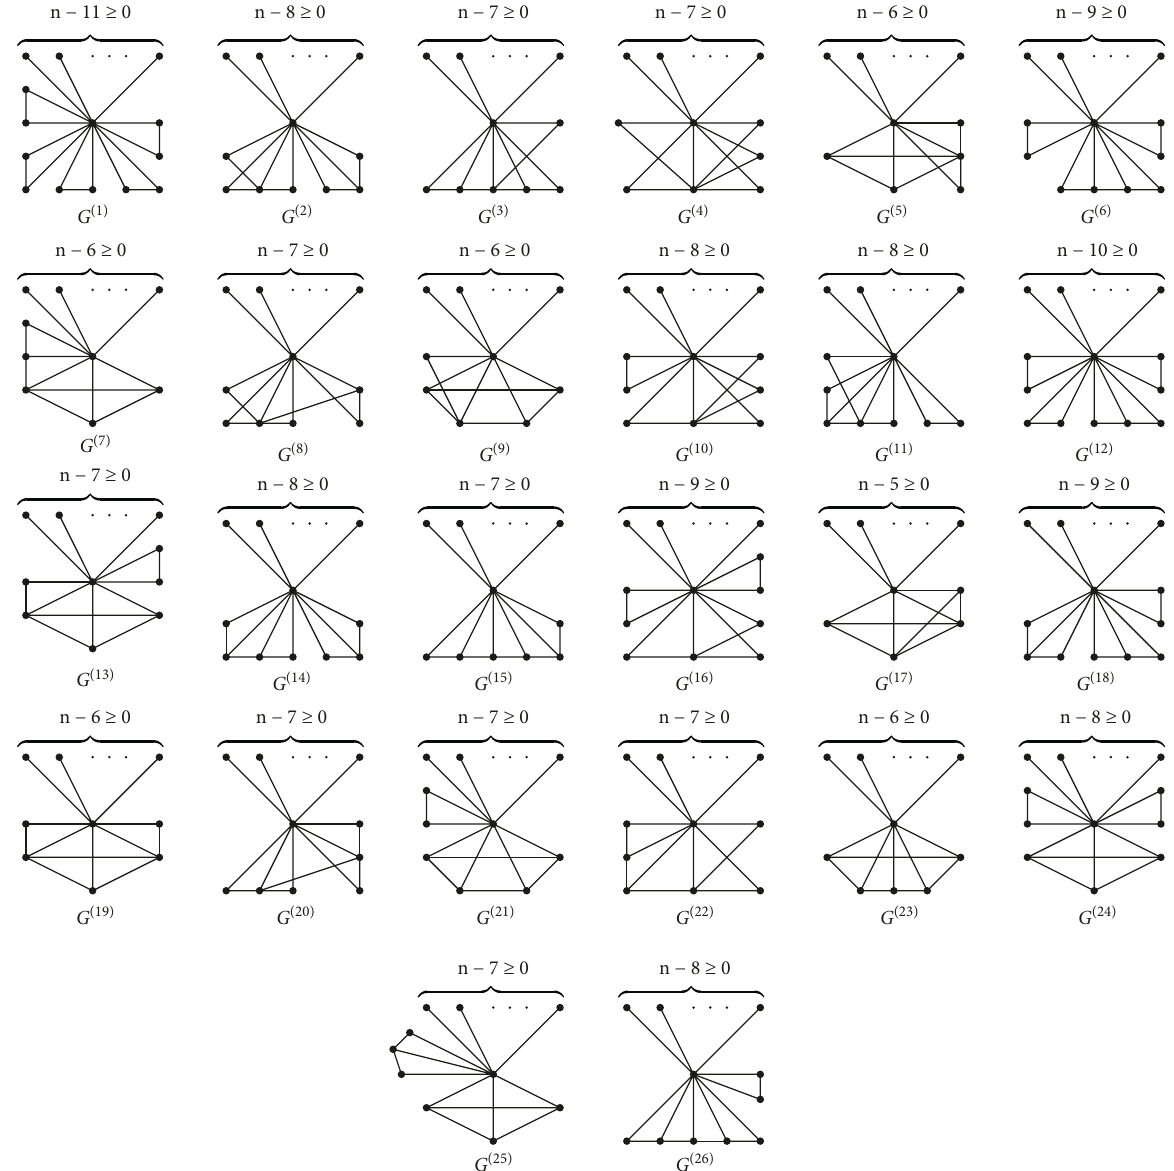
Figure 3: All possible pentacyclic graphs of order n and maximum degree n −